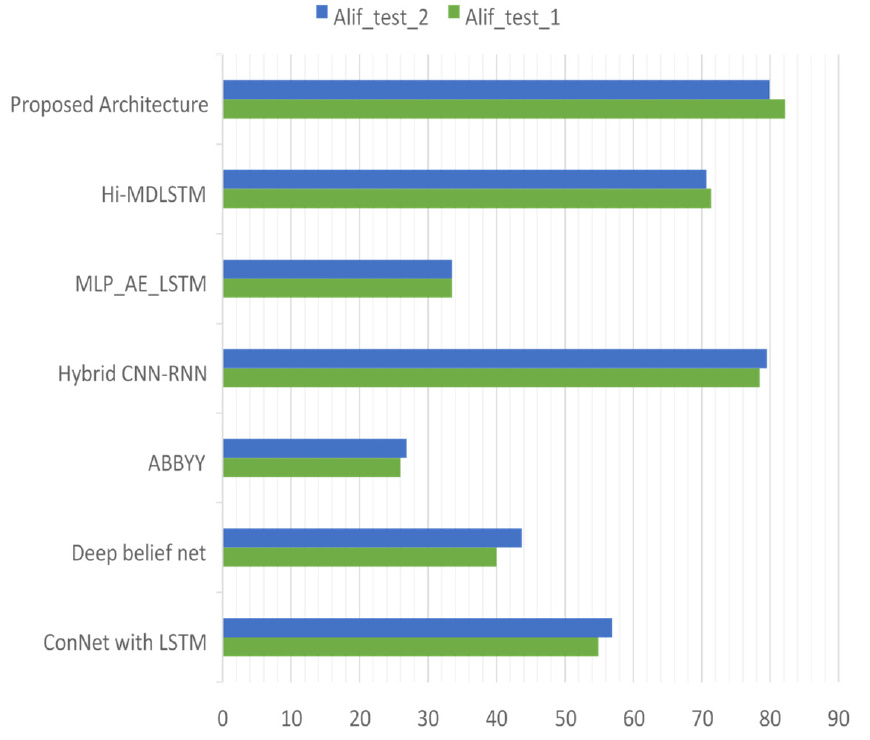
Figure 15. Comparison of proposed architecture with different architectures on line recognition rate (Alif dataset).